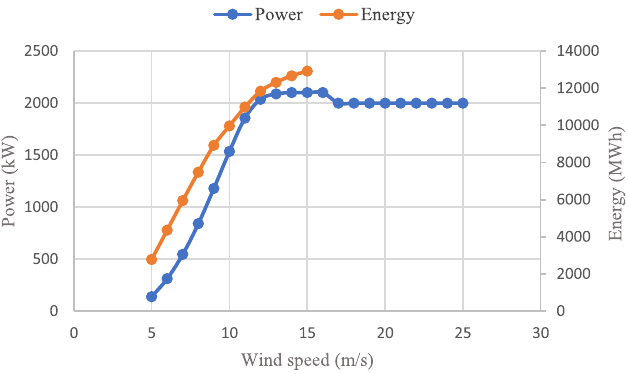
Fig. 12. CHG reduction comparison to the